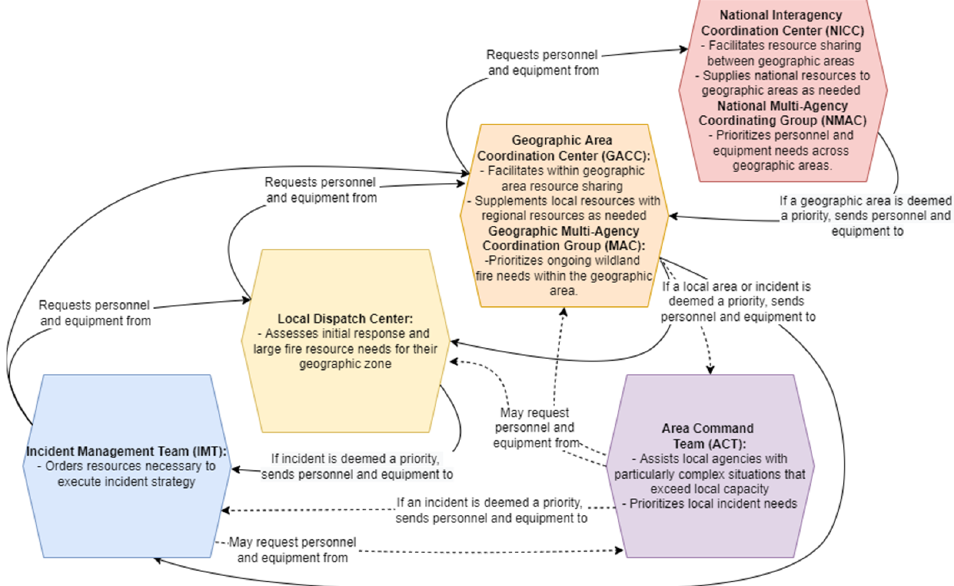
Figure 2. A conceptual diagram of the wildland fire resource allocation system in the US. Each hexagon represents an entity responsible for ordering and/or assigning resources to one or more of the other entities. A description of their responsibilities with regard to resource ordering and/or assignment is included within the hexagon. Entities higher on the diagram are responsible for management at a larger spatial scale. Arrows indicate the direction that requests and assignments flow. Dashed lines indicate requests and assignments associated with ACTs, which are typically only activated when there is a need to support multiple ongoing fires occurring in close proximity. There is a single national coordinating center, ten geographic area coordination centers (see Figure 1 for geographic area boundaries), and multiple local dispatch centers associated with each geographic area. There were three ACTs active in the US during the 2020 fire season and 59 Type 1 and Type 2 IMTs.